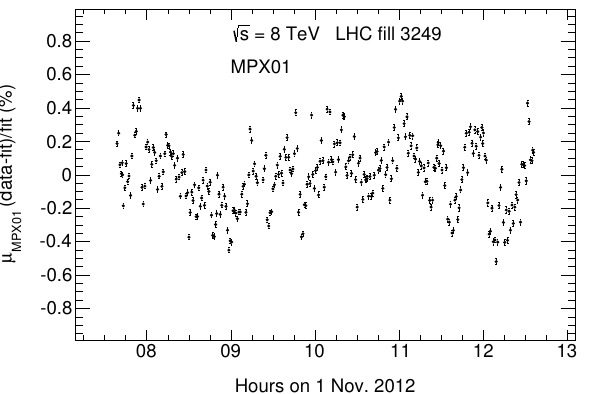
Figure 20. Deviations between data and the fit of the average number of interactions per bunch crossing as a function of time seen by MPX01. The relative deviations between data and fit have a root mean square RMS of 0.2%. The statistical uncertainties ∆ µ / µ per data point are indicated and √ √ vary from about 0.0099 2.65% to about 0.0116 2.65%, where the factor 2.65 is the averaged ratio of hits per interacting particle. The apparent structure is similar to the one previously discussed in the text. LHC fill 3249. Taken from Ref. [11]. Table 10. Same as Table 9, but for LHC fill 3249. The systematic uncertainties result from luminosity fluctuations not described by the fit function (taking σ fct sys = 0.02 and 0.03), shown in Figure 20. LHC fill 3249. Taken from Ref. [11]. MPX 01 ∆ µ